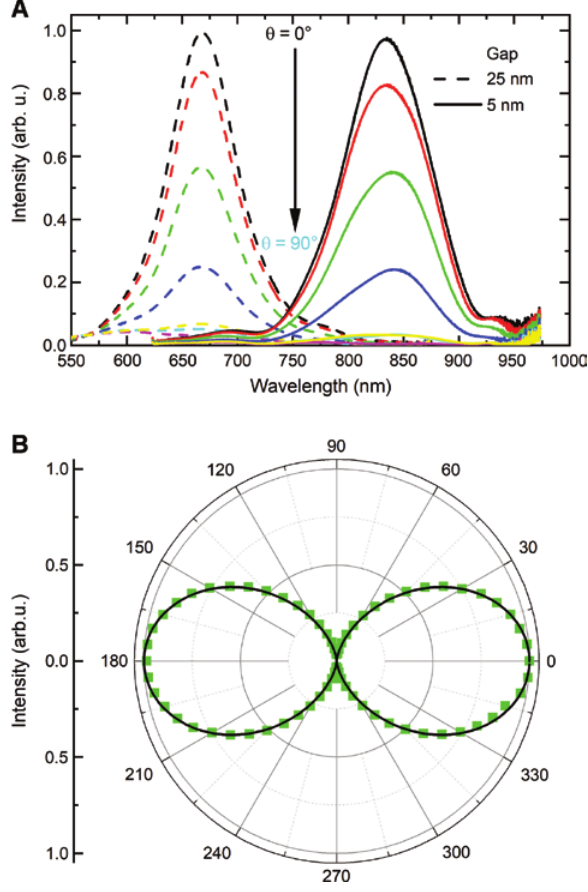
Figure 4: Polarisation dependence of the LSPR. (A) Polarisation-resolved linear scattering spectra recorded from SaP dimer antennas with gaps of 5 nm (solid lines) and 25 nm (dashed line) for different polarisation angles θ at linearly polarized excitation laser. (B) Angular plot of the spectrally integrated intensity (green squares) of the SaP dimer with a gap size of 5 nm together with a cos 2 ( θ ) fit (black